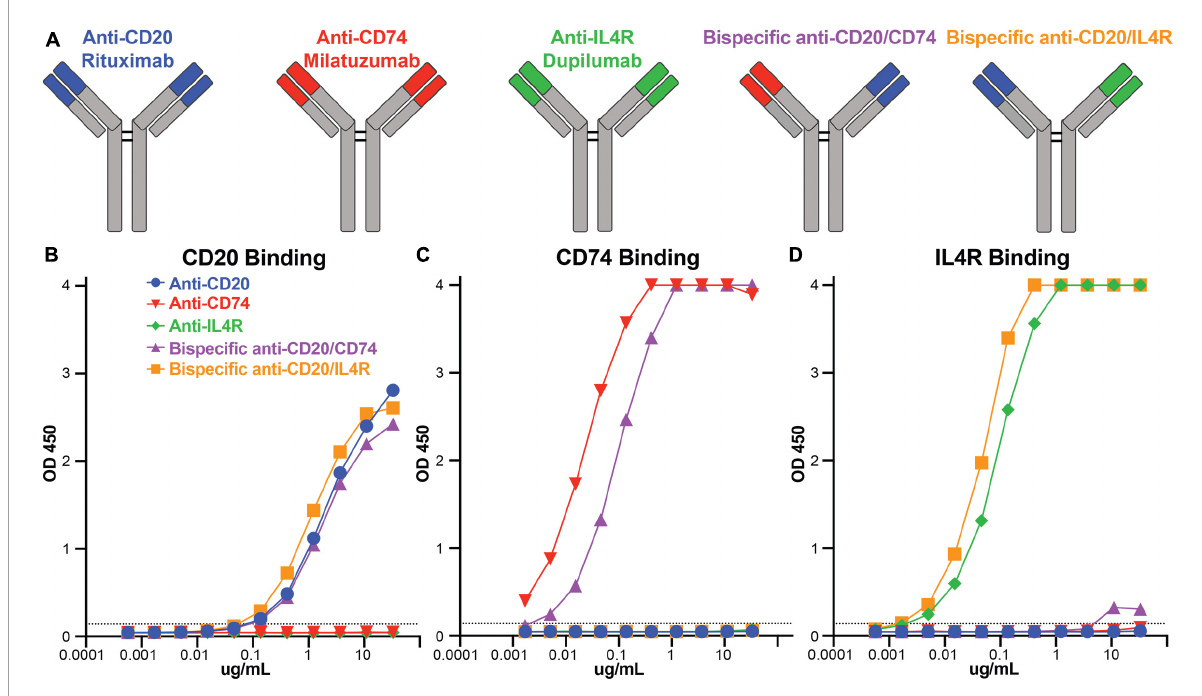
FIGURE2 Bispecific antibody construction and antibody binding responses. (A) Schematic representation of rituximab, milatuzumab, dupilumab, and the bispecific antibodies constructed with anti-CD20/anti-CD74 heavy chains and anti-CD20/anti-IL4R heavy chains. (B) Line graph of OD450 absorbance obtained by ELISA measuring antibody binding to CD20 at serial dilutions. (C) Line graph of OD450 absorbance obtained by ELISA measuring antibody binding to CD74 at serial dilutions. (D) Line graph of OD450 absorbance obtained by ELISA measuring antibody binding to IL4R at serial dilutions. Background absorbance, represented by the dashed line, was considered 3X blank well OD450